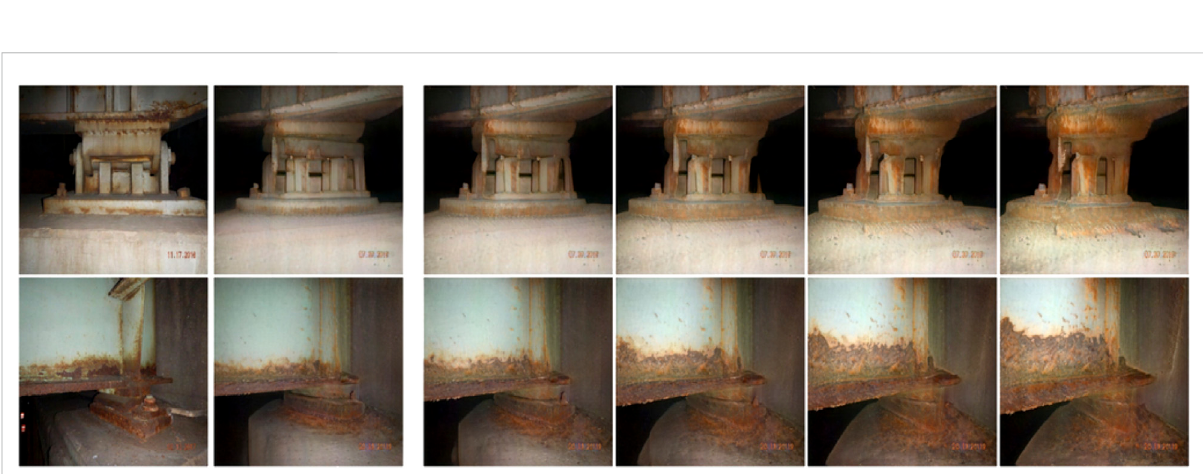
FIGURE 17 Examples of semantic deterioration forecasting where the fi rst image on the left is the real image, and the following images are the gradually translated version of the real image (Bianchi et al.,